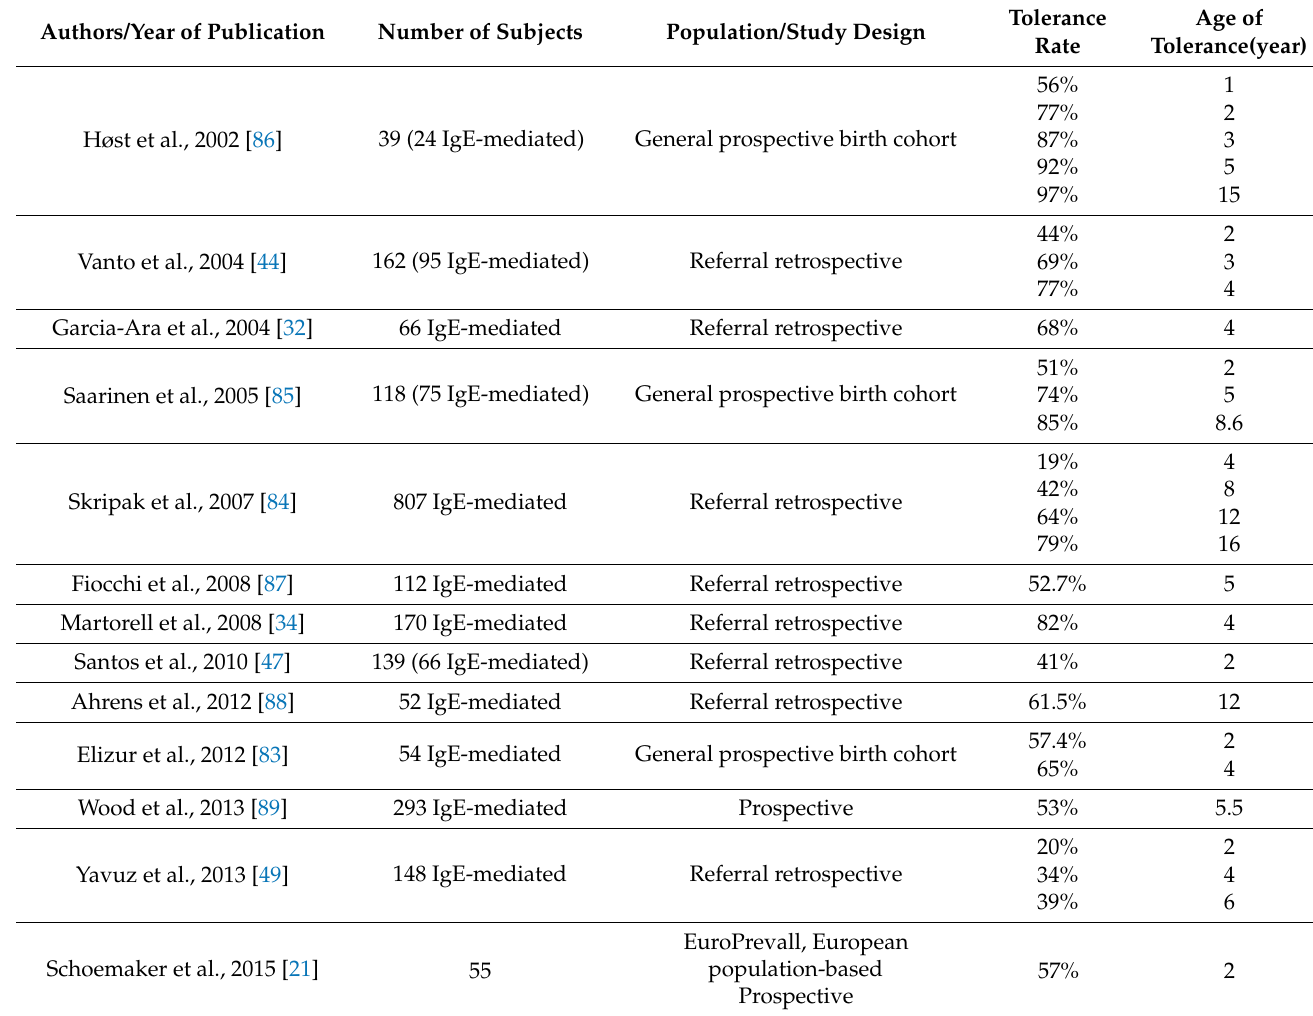
Table 4. Natural history of CMA in different populations and settings, adapted from Mousan et al.